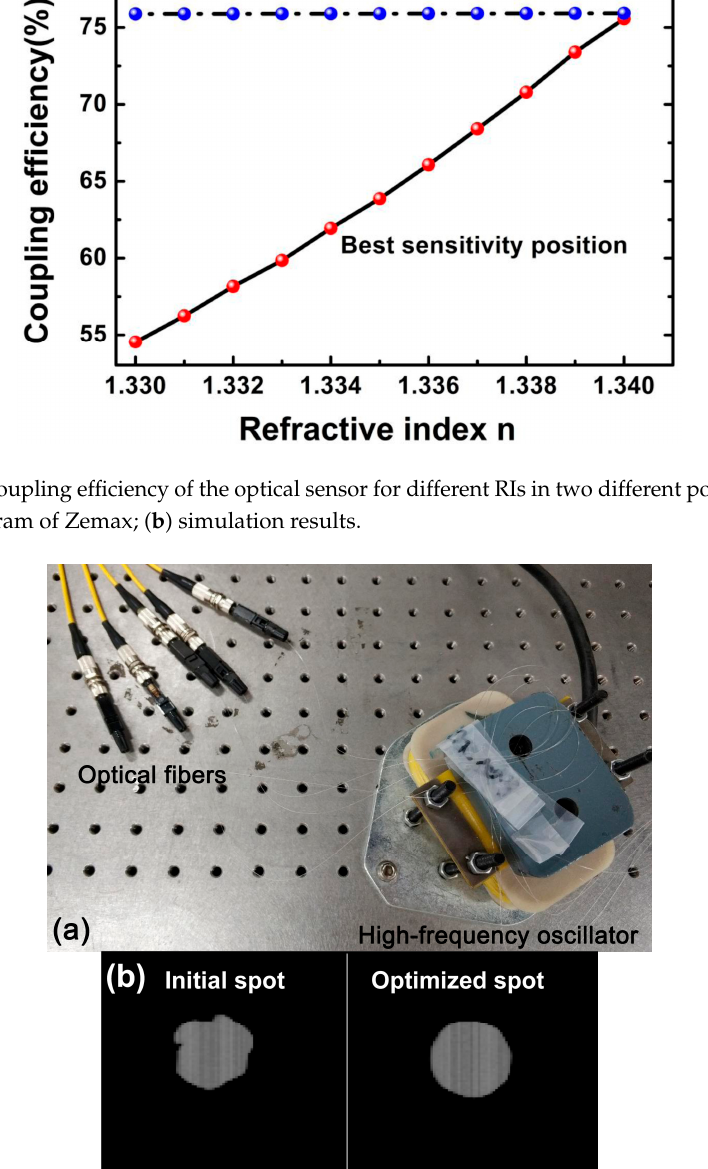
Figure 6. ( a ) Experimental setup of spot optimization; ( b ) the Charged Coupled Device (CCD) images of the initial and optimized spot. of the initial and optimized